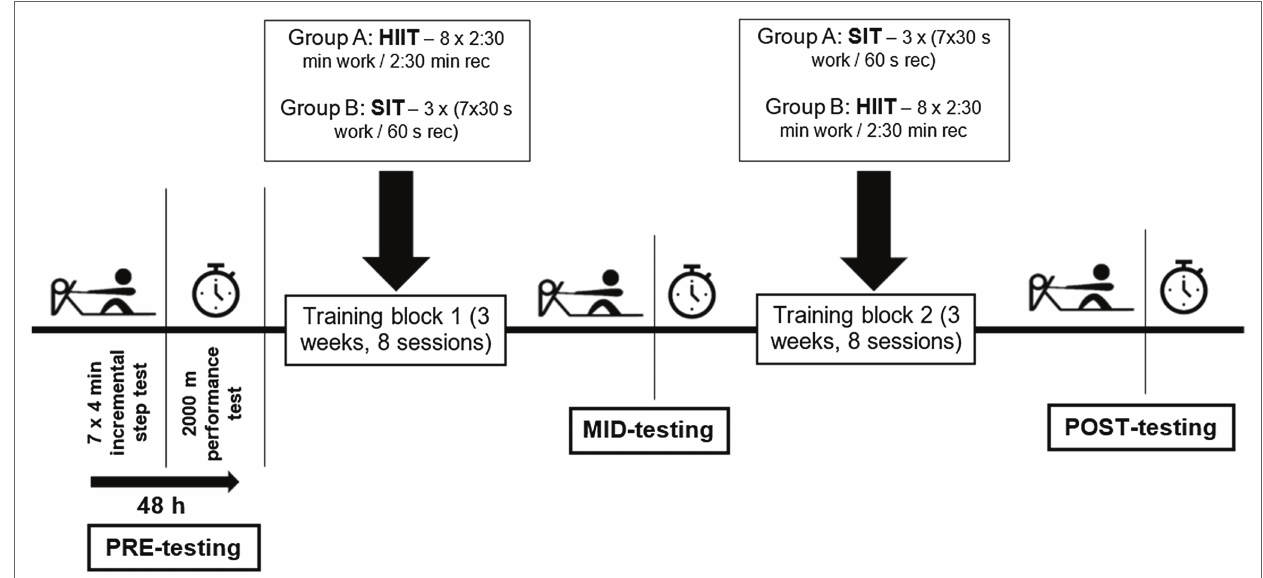
FIGURE 1 | Experimental design showing PRE, MID, and POST-testing time points interspersed with training allocations according to